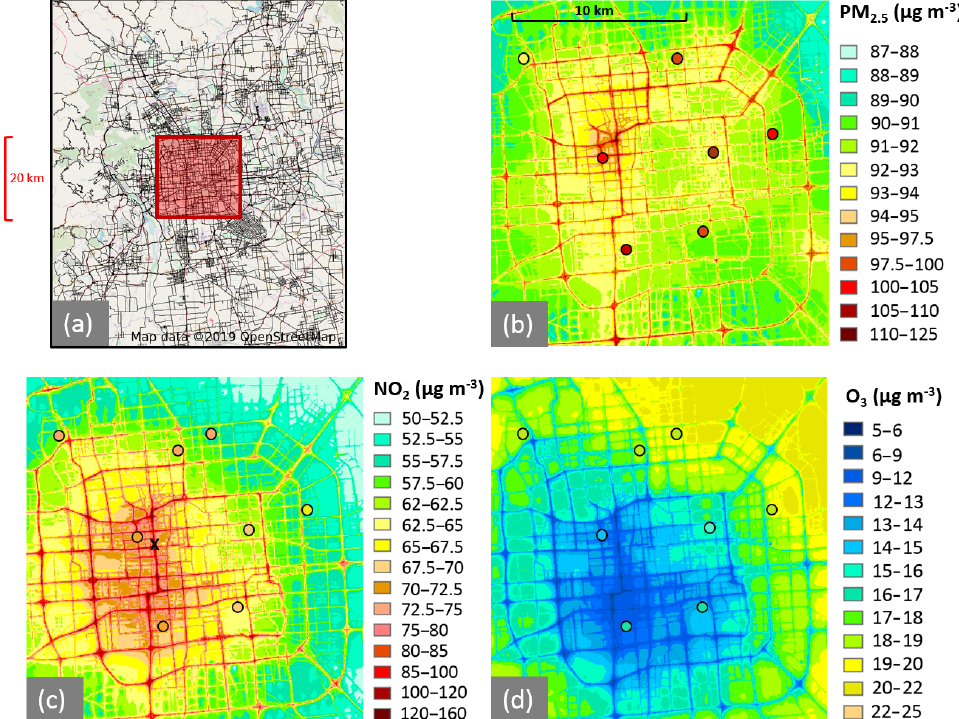
Figure 4. Spatial maps of mean PM 2 . 5 (b) , NO 2 (c) , and O 3 (d) concentrations for the winter campaign period (5 November to 10 Decem- ber 2016), simulated using the MEIC Opt emissions inventory. Simulated concentrations cover the region marked in (a) . Mean measured concentrations at monitoring network sites (NO 2 , O 3 and PM 2 . 5 ) and the IAP field site (NO 2 and O 3 ) are represented by coloured dots. © OpenStreetMap contributors 2019. Distributed under a Creative Commons BY-SA License.